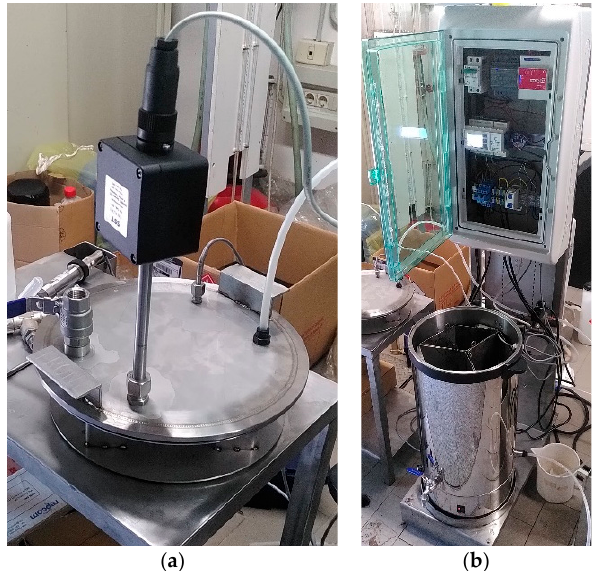
Figure 4. Further details of a bioreactor, showing: ( a ) Sensors on the covering sealing disk; ( b ) Front view of an open single biocell with its electronic control unit (Programmable logic controller).